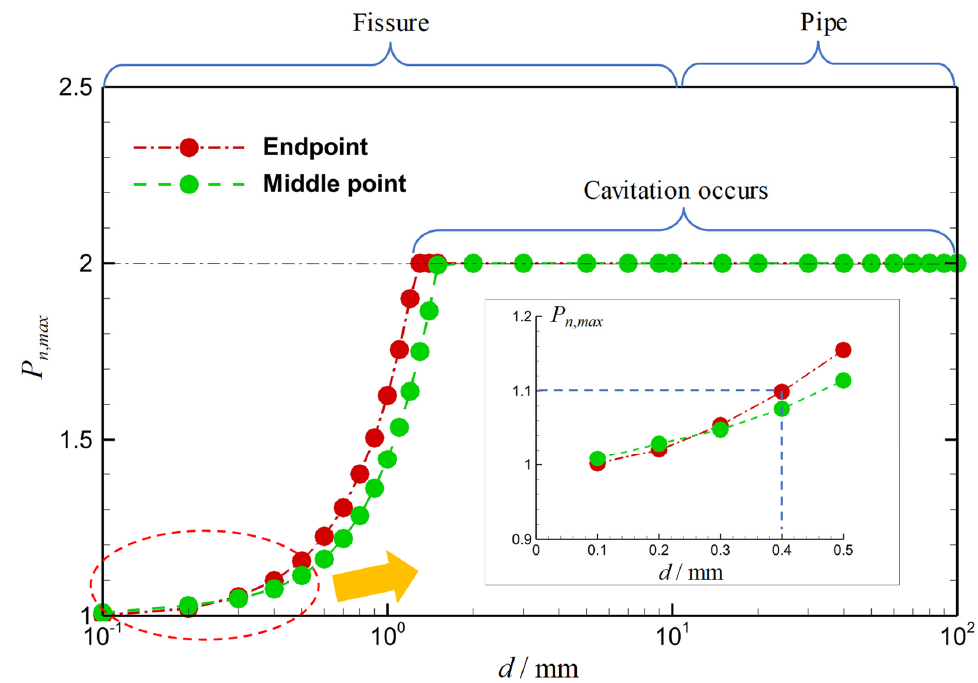
Figure 10. Distribution of normalized peak pressure P n , max where L x = 10 m and f = 25 Hz. When d ≥ 10 mm, d represents the diameter of the pipe. When d < 10 mm, d represents the aperture of the fissure. Table 1. Inhibition or magnification effects of the pulse at midpoint and endpoint (partial data). Peak Pressure at Peak Pressure at d (mm) Effect Effect Midpoint Endpoint 0.1 1.009 ✗ 1.002 0.2